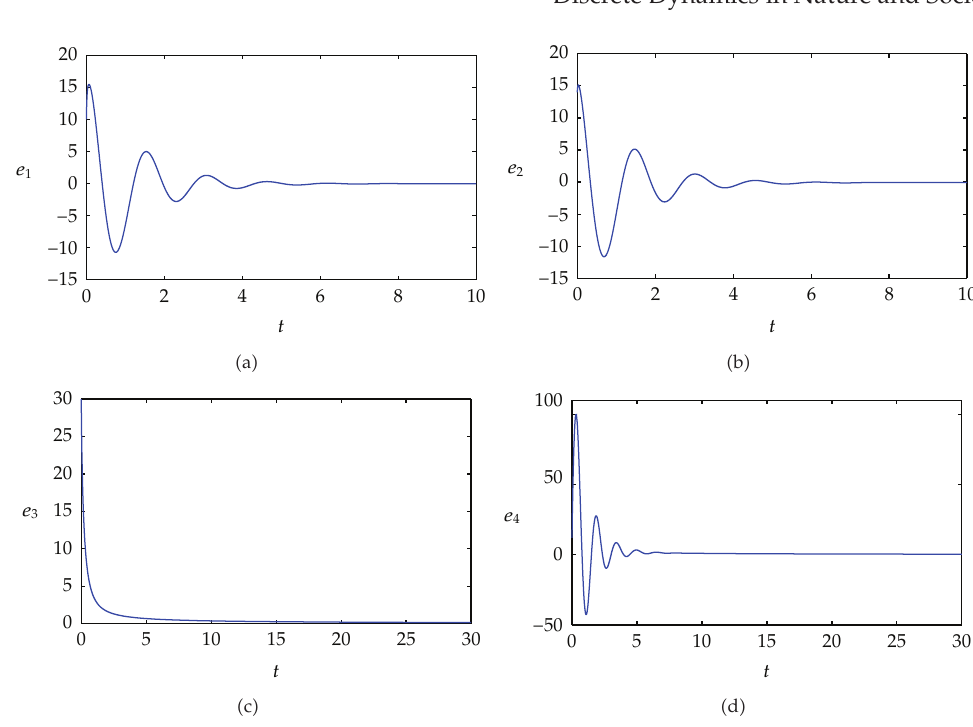
Figure 2: The control simulation result for (cid:6) 0, 0, 19, 0 (cid:7) when q (cid:5) 0 .